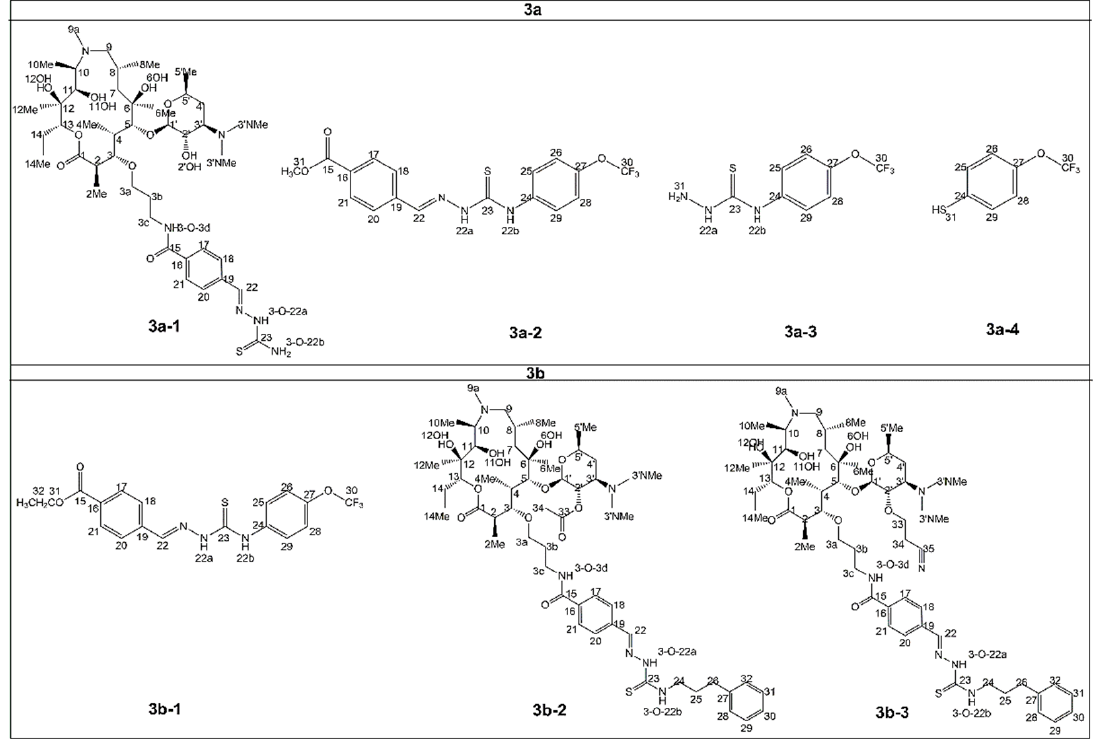
Figure 3. Structures of reaction components not related to stereoisomers.